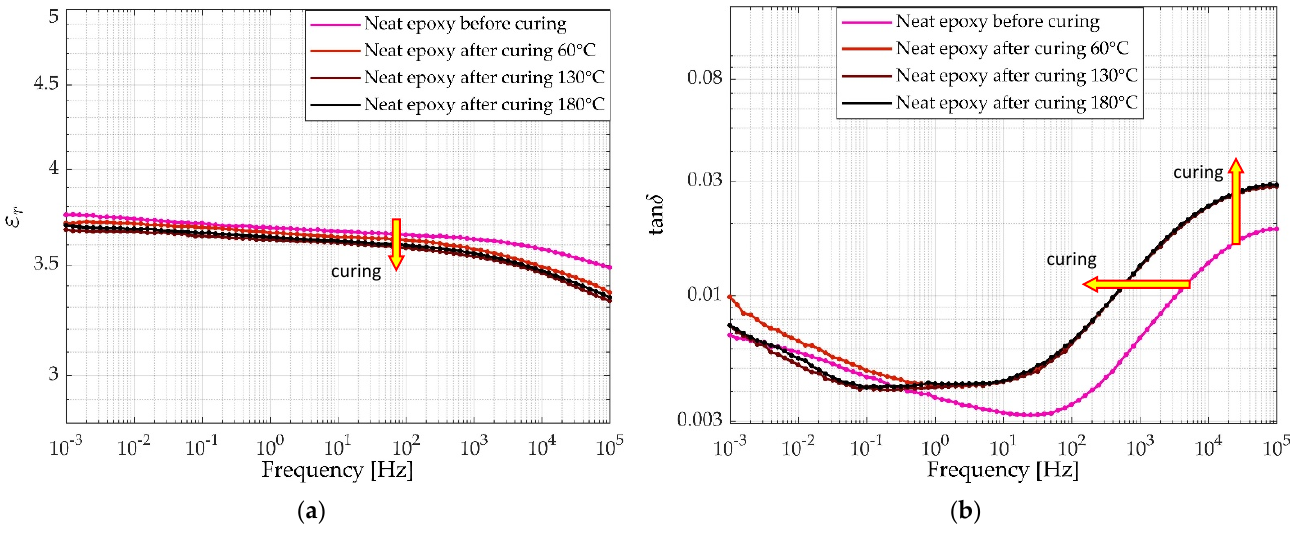
Figure 2. Broadband characteristics of dielectric constant ε r ( f ) ( a ) and dielectric loss factor tan δ ( f ) ( b ) for neat epoxy specimens before and after subsequent thermal curing cycles.